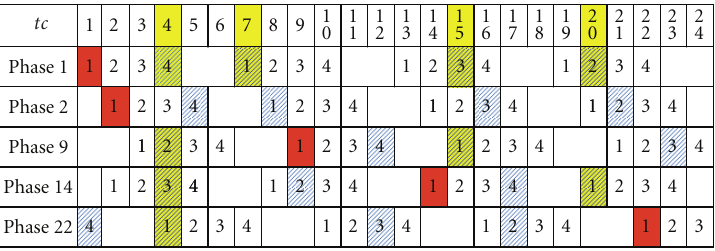
Figure 5: Illustration of the code search process. Assume that the TH sequence is { 4,1,3,2 } , N th = 4, and N f = 6. Let the code search start from chip 1. The chips in yellow correspond to when there is a received pulse at the receiver. The shaded chips are the chips when there should be a pulse for the corresponding phase. The red chips represent the bit starting